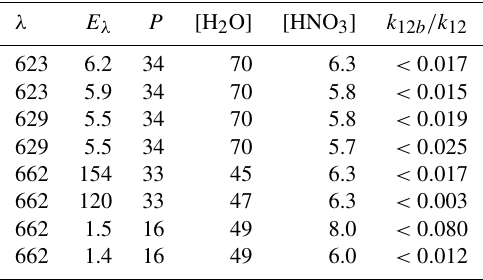
Table 2. Experimental conditions and results for NO ∗ action R12).